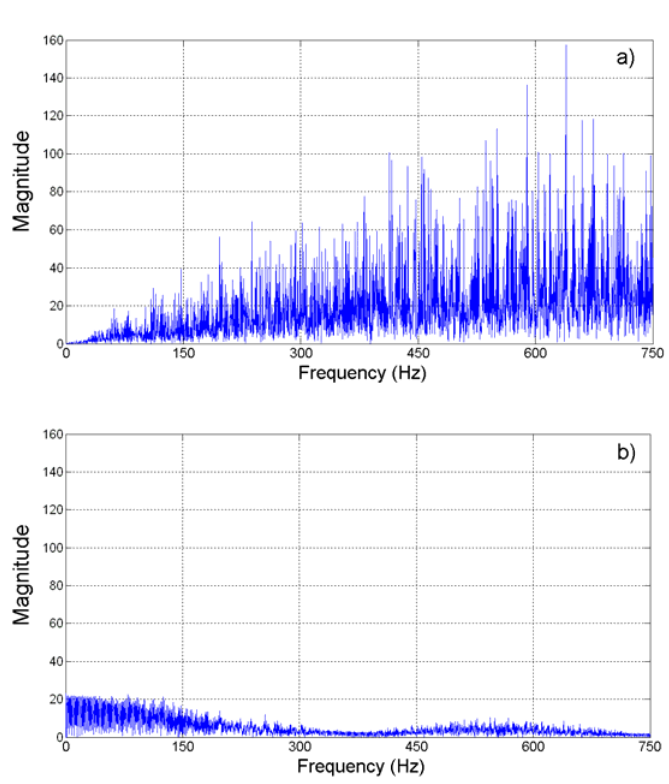
Figure 9. Spectra of quantization error for jerk estimation. (a) Nyquist rate. (b) 4-times oversampling. (c) 8-times oversampling. (d) 16-times oversampling. (e) 32-times